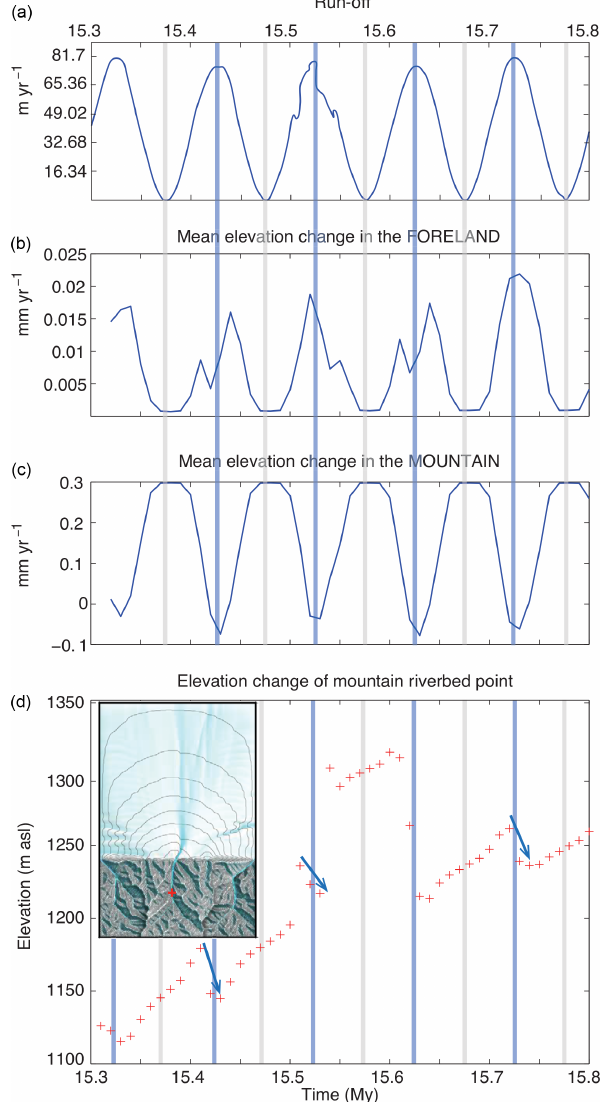
Figure 6. Experiment 2b (sinusoidal precipitation). Temporal evo- lution of (a) run-off and (b) mean elevation change in the foreland and (c) in the mountain. The trends of mean elevation change in the mountain and in the foreland are inversely correlated, and they show a slight delay relative to the change in run-off, corresponding to the response time. (d) Temporal elevation change of the central valley floor in the mountain (location marked by red cross on inset map) during Experiment 2b. The incision (blue arrows) related to humid periods (blue vertical lines are maximum run-off) is (over-) compensated for in drier periods (grey vertical lines correspond to no run-off) by the uplift, so that the elevation generally increases through the experiment. The maximum incision is delayed from the maximum run-off (response time). Temporary deposits at the valley outlet around 230kyr dam the valley and trigger rapid backfilling of it, responsible for the high elevation between 230 and 310kyr; the following incision episode removes this dam.